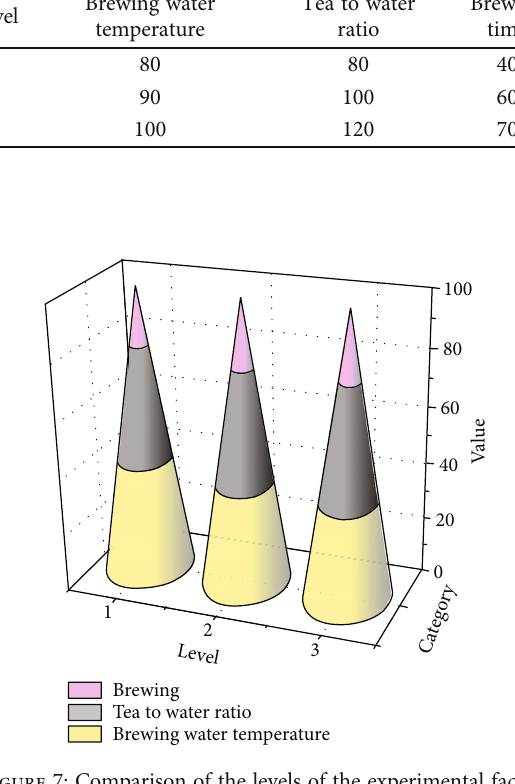
Figure 7: Comparison of the levels of the experimental